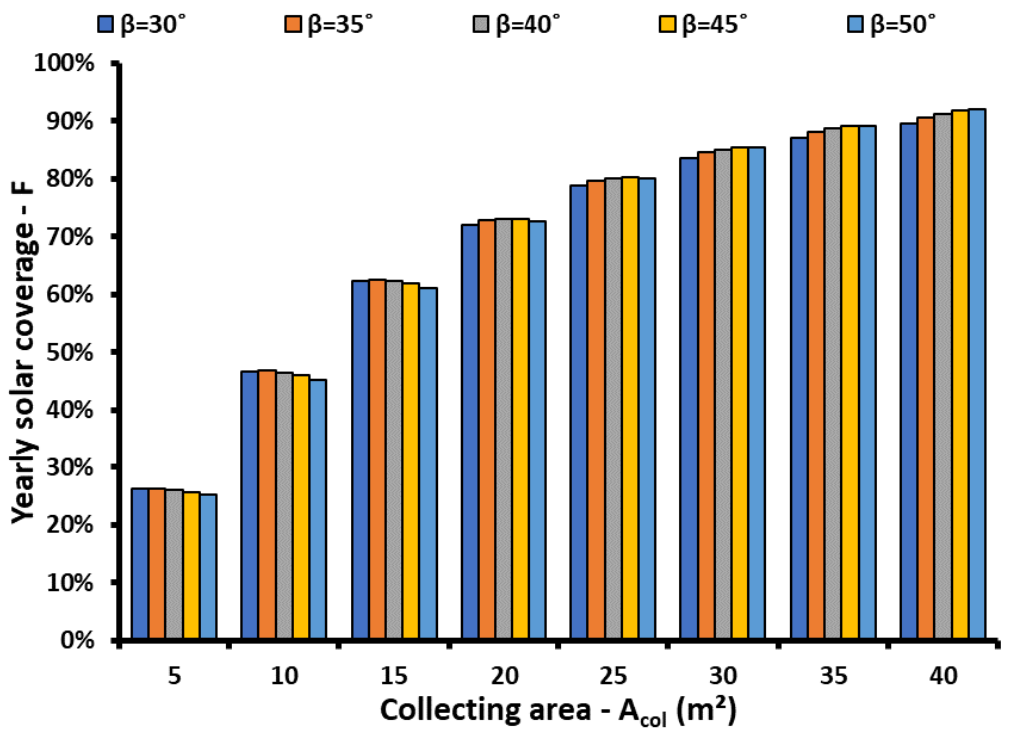
Figure 5. The impact of the solar field area and of the tilt angle on the yearly solar coverage for Athens and the advanced FPC.